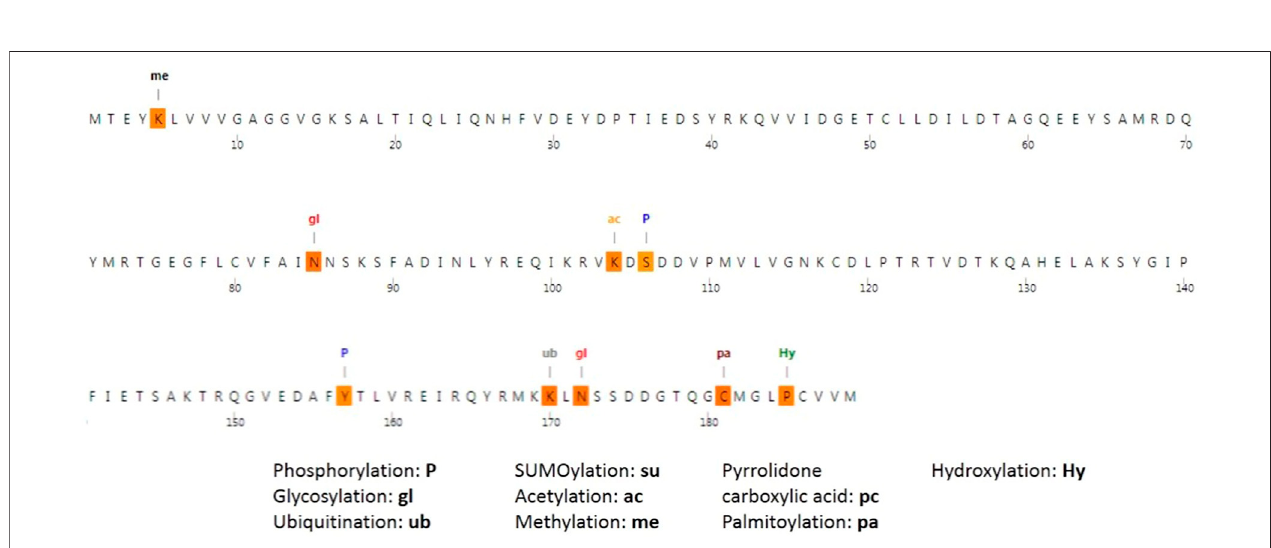
FIGURE 7 | Post-translational modi fi cations of NRAS produced by the MusiteDeep server.